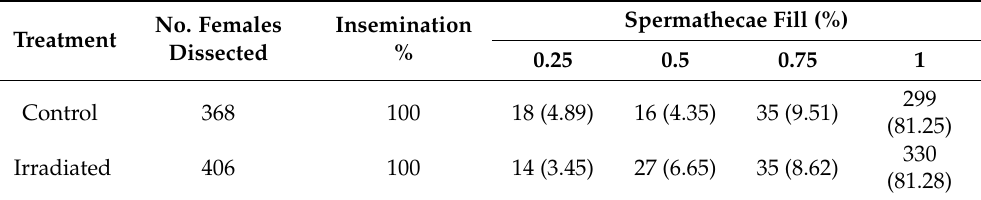
Table 2. Reproductive status of Glossina palpalis gambiensis females mated with irradiated and non- irradiated males dissected after 12 days of